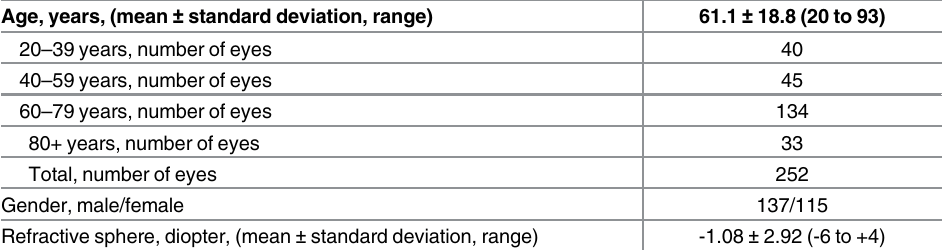
Table 1. Systemic and Ocular Characteristics of Healthy Japanese Recruited in the Current